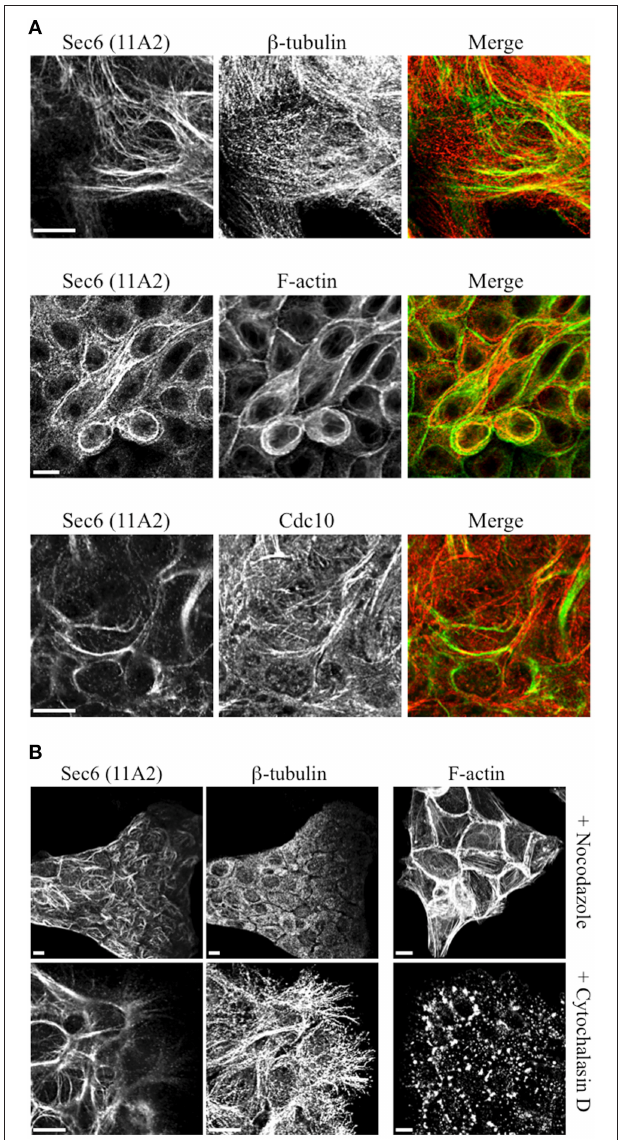
FIGURE 6 | Characterication of filamentous Sec6 mAb 11A2 labeling. (A) MDCK cells were fixed with either 100% methanol (top and bottom rows) or 4% paraformaldehyde (middle row) and co-labeled with antibodies to Sec6 CT2b (mAb 11A2) and either β -tubulin or Cdc10 or with phalloidin. Bars = 10 µ m. (B) MDCK cells were treated with either nocodazole or cytochalasin D, as described in Material and Methods. Cells were fixed with 100% methanol and co-labeled with antibodies to Sec6 CT2b (mAb 11A2) and β -tubulin. Panels on the right show cells that were fixed with 4% paraformaldehyde and labeled with phalloidin to demonstrate appearance of the actin cytoskeleton following treatment with drugs. Bars = 10 µ